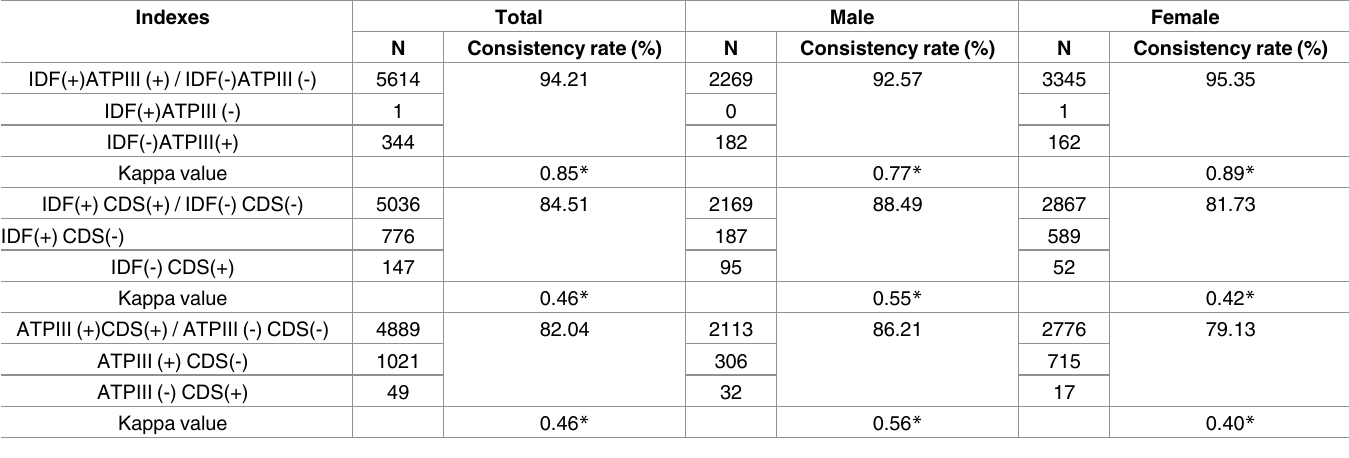
Table 5. Consistencies in the diagnoses of MS according to the three